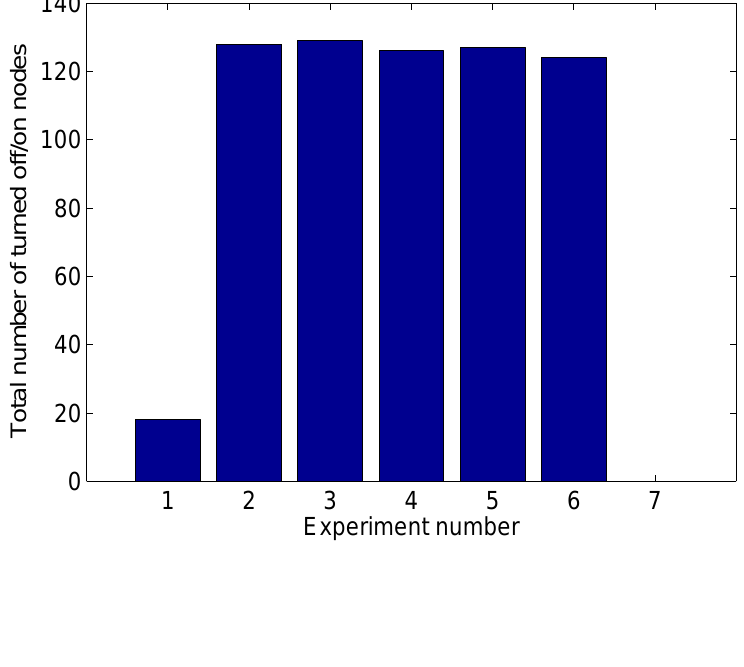
for T = 25 s and on cycle